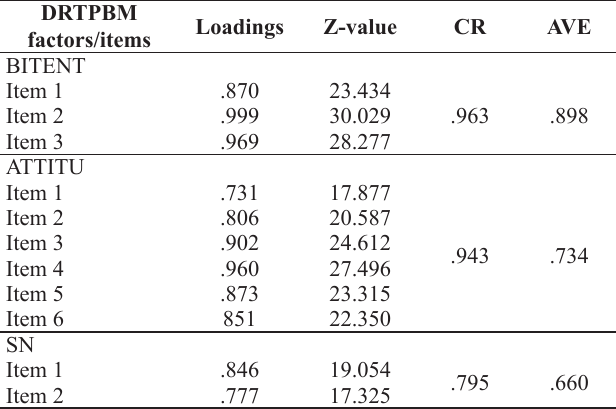
Table 4. Portuguese version of DRTPBM Re-specified first Order Model-Factor Loading, Z-values, Composite Reliability (CR) and Average Variance Extracted (AVE).